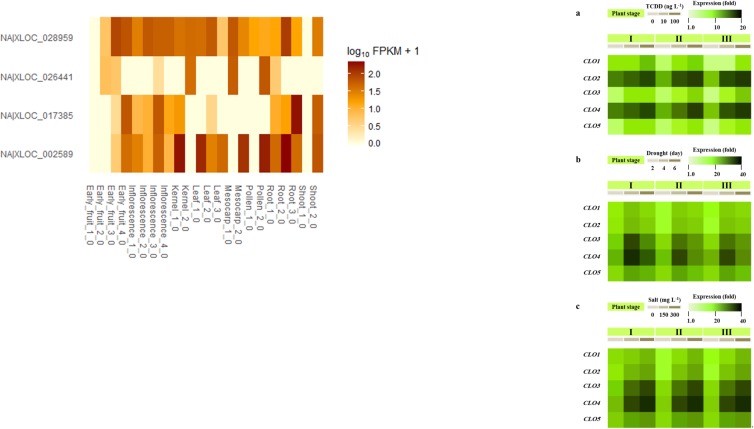
Transcriptome analysis of CLO/PXG gene expression in date palm and oil palm tissues.(A) The oil palm genome P5-build was used to read map the RNA seq data from Roche 454 reads (a full dataset is available from NCBI BioProject PRJNA201497). Reads from Roche/454-derived libraries were assembled into isotigs, which were blasted onto Arabidopsis thaliana gene models with a threshold of E-value < 10−5. The best-hit A. thaliana gene model was assigned to the homologue of the query isotig. To estimate expression levels of genes in mesocarp and kernel tissues, Illumina HiSeq 2000 reads from each library were mapped to assembled isotigs from all Elaeis guineensis reads by using the Burrows–Wheeler Aligner. Gene group expression levels were calculated as the number of mapped reads on each isotig divided by the total number of isotigs, multiplied by 100,000, and scaled by the number of genes in each gene group. Both copy number and read coverage were the mean of measures from two biological replicates. Data were analysed as described above for Roche/454 data, except that expression levels were calculated as transcripts per million tags. Identification of expression caleosin in oil palm was done using open source Tuxedo suite software[50]. (B) Transcriptional analysis of CLO/PXG gene expression in date palm tissues and treatments as follows: a) exposure to 0, 10 and 100 ng.L-1 of the dioxin, TCDD; b) drought for 2, 4 and 6 days; c) exposure to 0, 150 and 300 ng.L-1 NaCl. Seedlings with a radicle length of 0.5 or 2 or 4.5 cm were referred as stage I, II and III respectively.